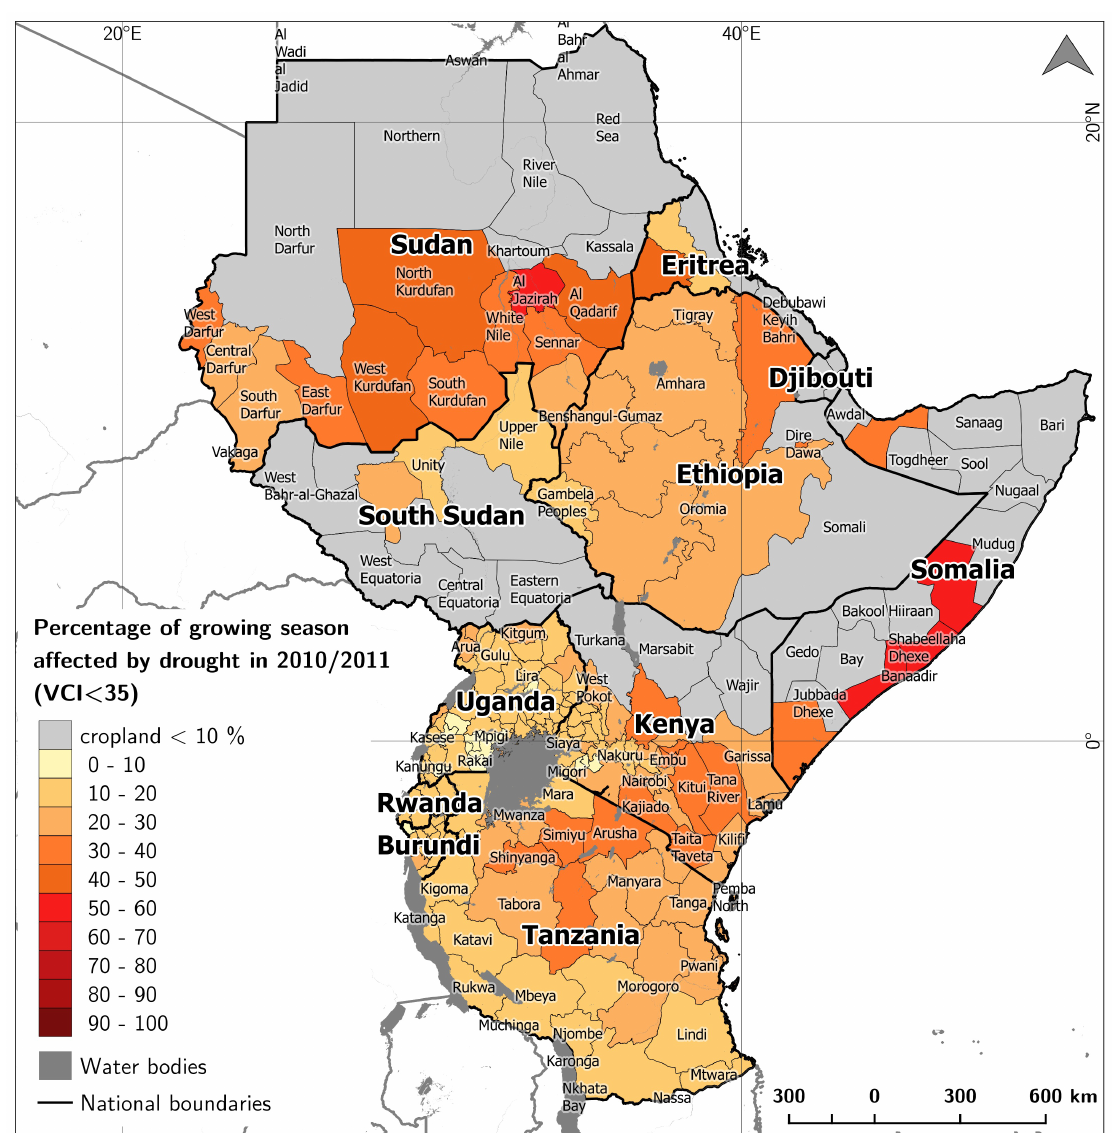
Figure 11. Duration of agriculturally relevant droughts in East African regions during